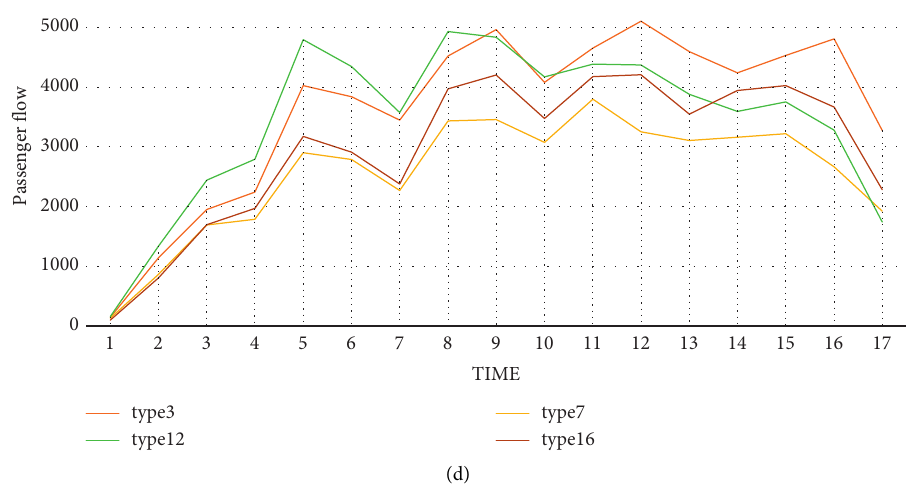
Figure 4: Trend of passenger flow